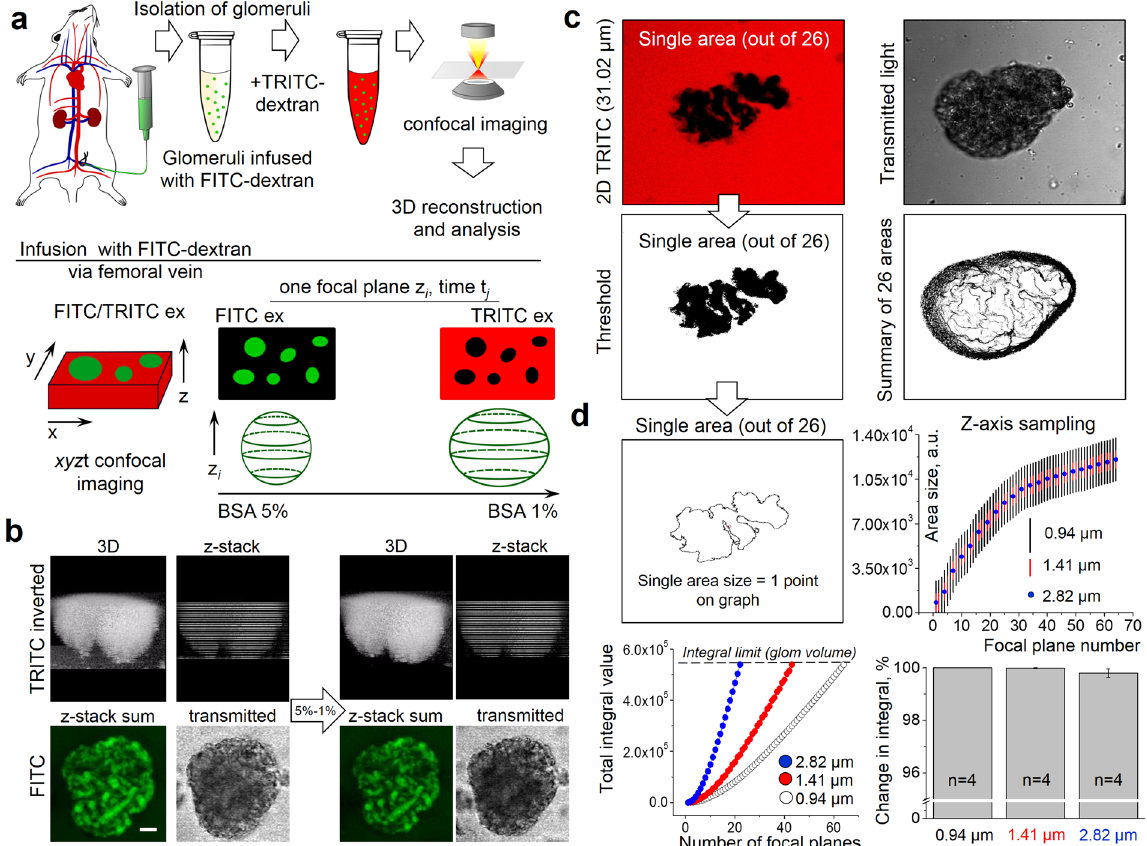
Figure 1. Schematic explanation of the measurements of glomeruli permeability and volume changes. ( a ) General steps of the glomeruli permeability assay: surgical preparation of the anesthetized animal and injection of 150 kDa FITC-dextran into circulation via femoral vein; glomeruli isolation, incubation and addition of 150 kDa TRITC-dextran into the solution containing FITC-labeled glomeruli; fast xyzt confocal fluorescence microscopy scanning during the changes in oncotic gradient (BSA 5% to 1%); 3D reconstruction and image analysis of glomerular volume and inner fluorescence changes. ( b ) Example of glomerular volume reconstitution and image analysis for the permeability assay. Fluorescence intensity was summarized from corresponding FITC values and subsequently analyzed. Also shown is a transmitted light image of a single glomerulus. Arrow illustrates solution change from 5% to 1% BSA. Scale bar is 20 µ m. ( c ) Glomeruli volume reconstitution. To assess the glomerulus volume, images from 26 focal planes with a slice thickness of 2.82 μ m were obtained along the z-axis of each glomerulus. Shown here (“2D TRITC”, left upper panel) is an example of a scanned area from the middle of the imaging stack (slice 11 out of 26, which corresponds to 31.02 μ m on z-axis), that reveals a detailed structure of glomerulus (black) covered with TRITC-dextran (red). Adjusted threshold level used to calculate slice area in the Analyze Particles Module (ImageJ), as well as a 3D summary of all areas for current glomerulus are shown in the right panel. ( d ) Glomerular volume calculation. Shown on the left (upper panel on D ) is a single area used to calculate the glomerulus volume. Right upper panel demonstrates three different sampling rates (2.82 (26 z-slices), 1.41 (52 slices) or 0.94 μ m (78 slices)), each point on the graph corresponds to the size of the single area (shown on left). Total integral value for each sampling rate, and the summary bar graph (lower panel) demonstrate that independently of the size of the z-axis step, total integral value (glomerulus volume) riches the same